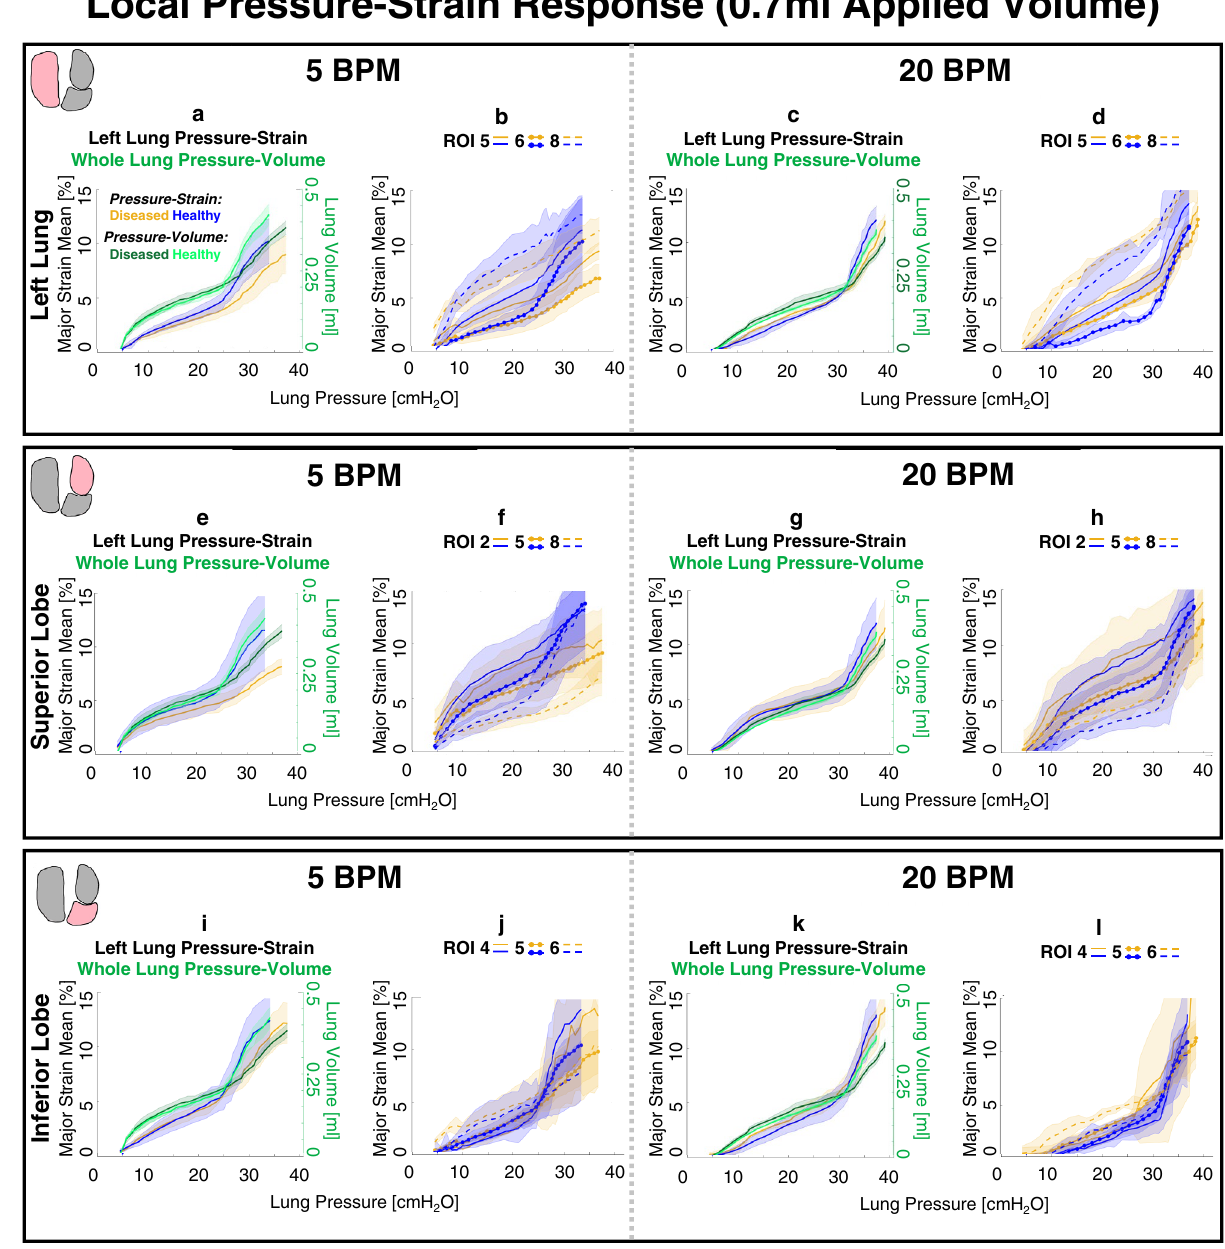
Figure 8. Local compliance pressure-strain curves for diseased and healthy murine lung specimens (gold and blue, respectively) compared to global lung pressure–volume compliance curves (green) and select ROIs of each lobe at both breathing rates (5 and 20 BPM), for an applied inflation volume (0.7 ml), for the left lung ( a – d ), superior lobe ( e – h ), and inferior lobe ( i – l ). Curve shadows represent the average ± standard deviation across specimens in the diseased or healthy